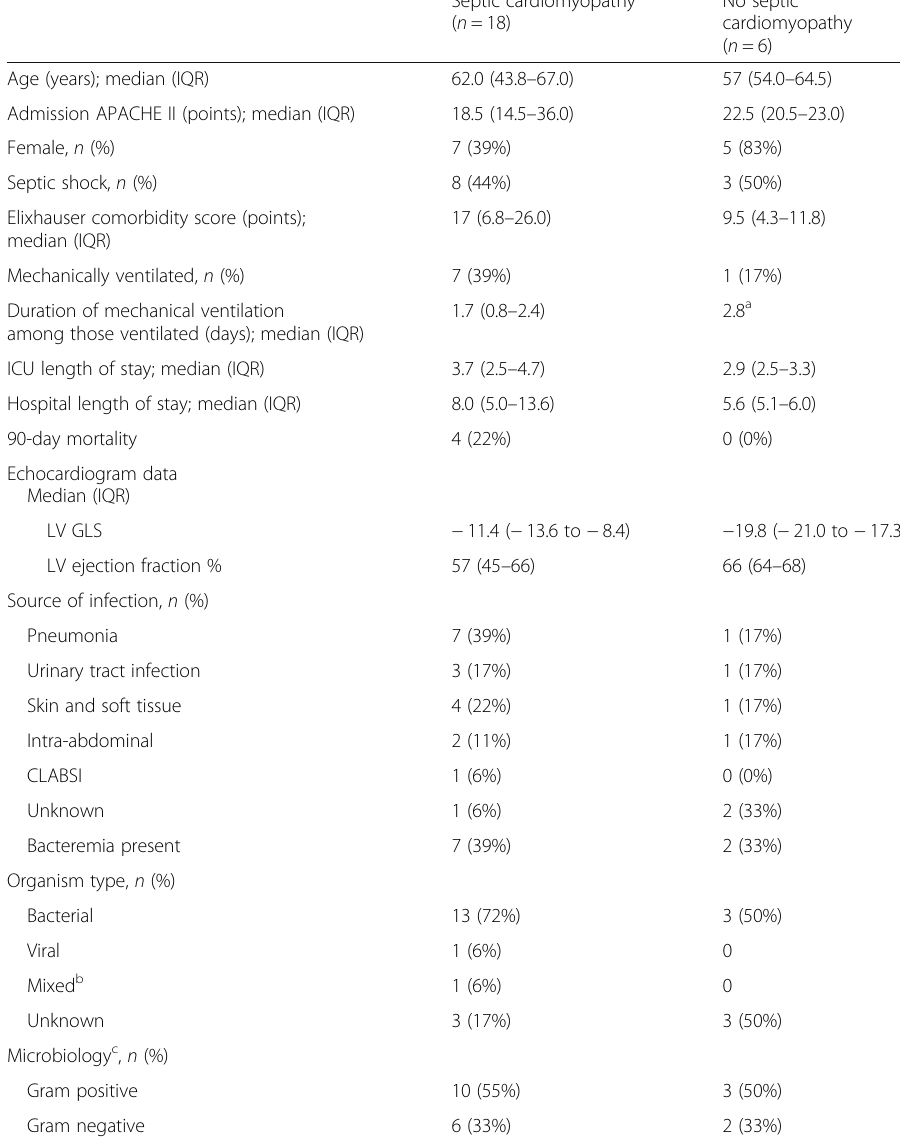
Table 1 Characteristics of patients with and without septic cardiomyopathy